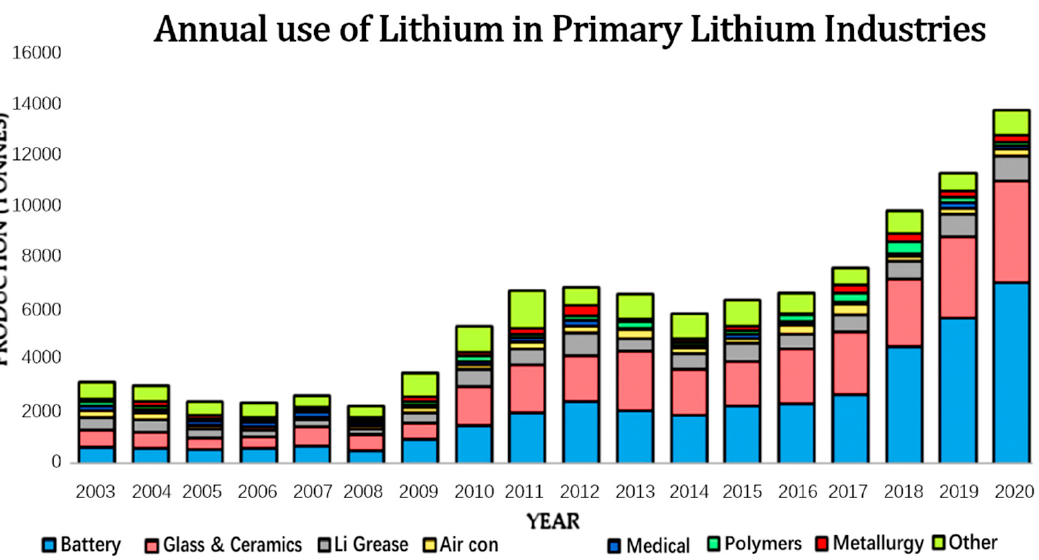
Figure 1. Annual use of lithium in tonnes in each of the primary lithium usage industries from 2003– 2010 [9]. 2003–2010